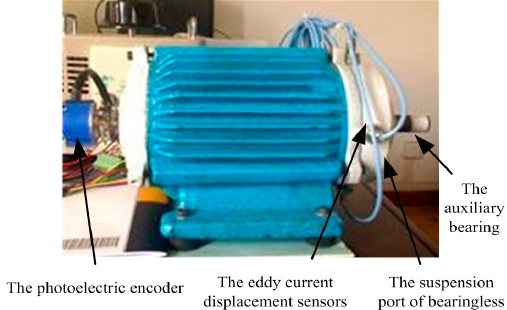
Figure 7. Prototype physical diagram.